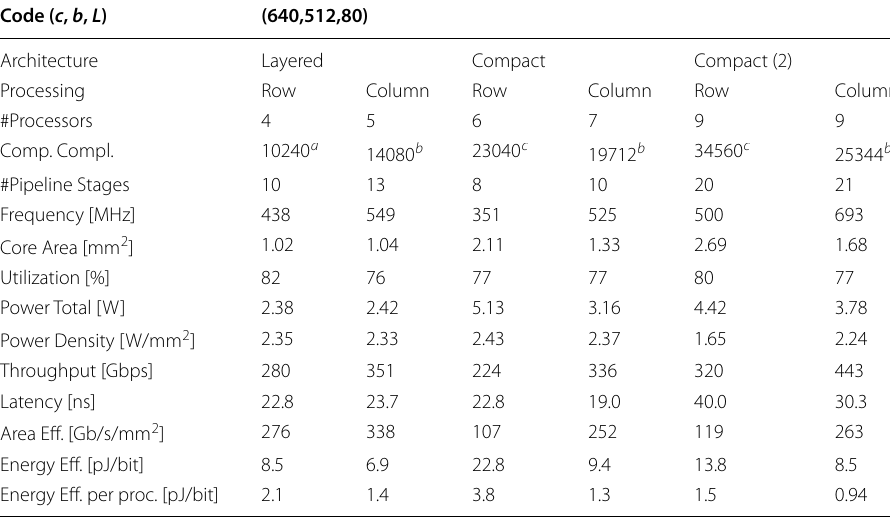
a Calculated using E row · I since no exchange messages are processed. b Calculated using Eq. 8. c Calculated using Eq.